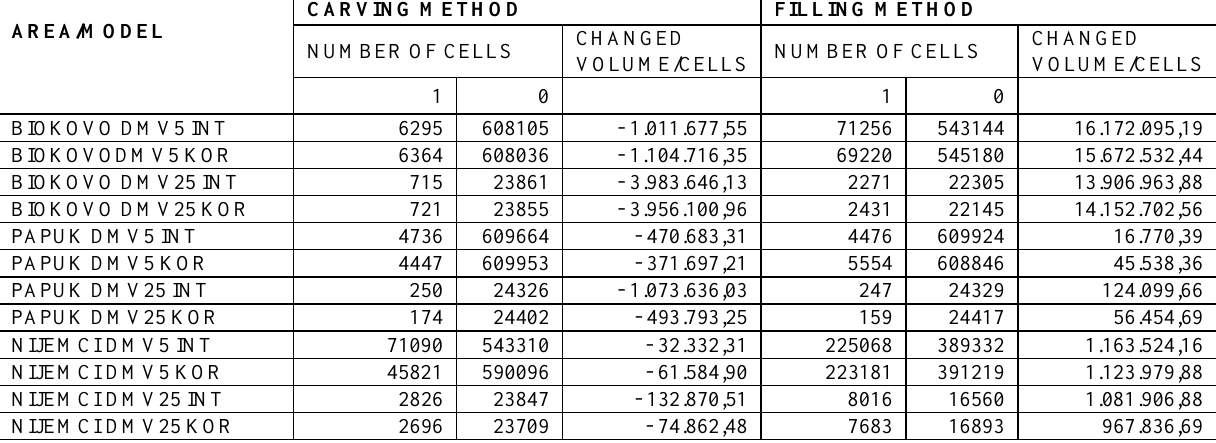
Table 2: The number of changed cells (values1) and total changed volume in cubic meter after the pit removal by carving method and filling